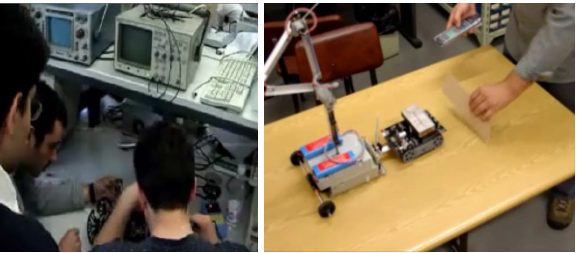
Figure 1. Car remote control and Robotic arm in PESC1 and PESC2 project